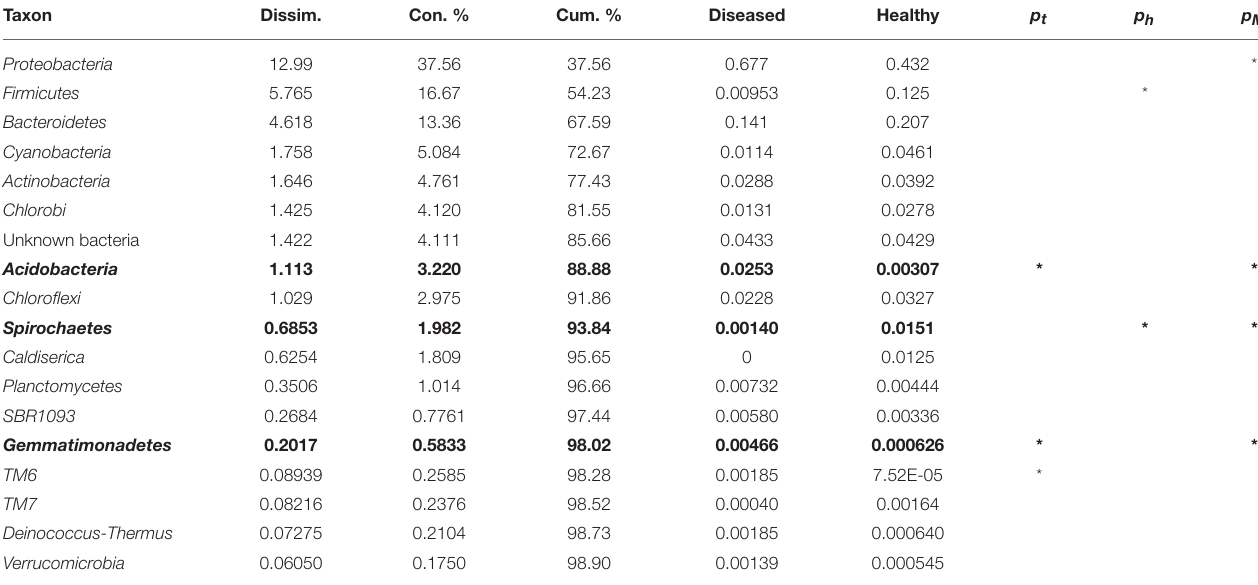
TABLE 2 | Summary of SIMPER analysis results for the major phyla. Taxon